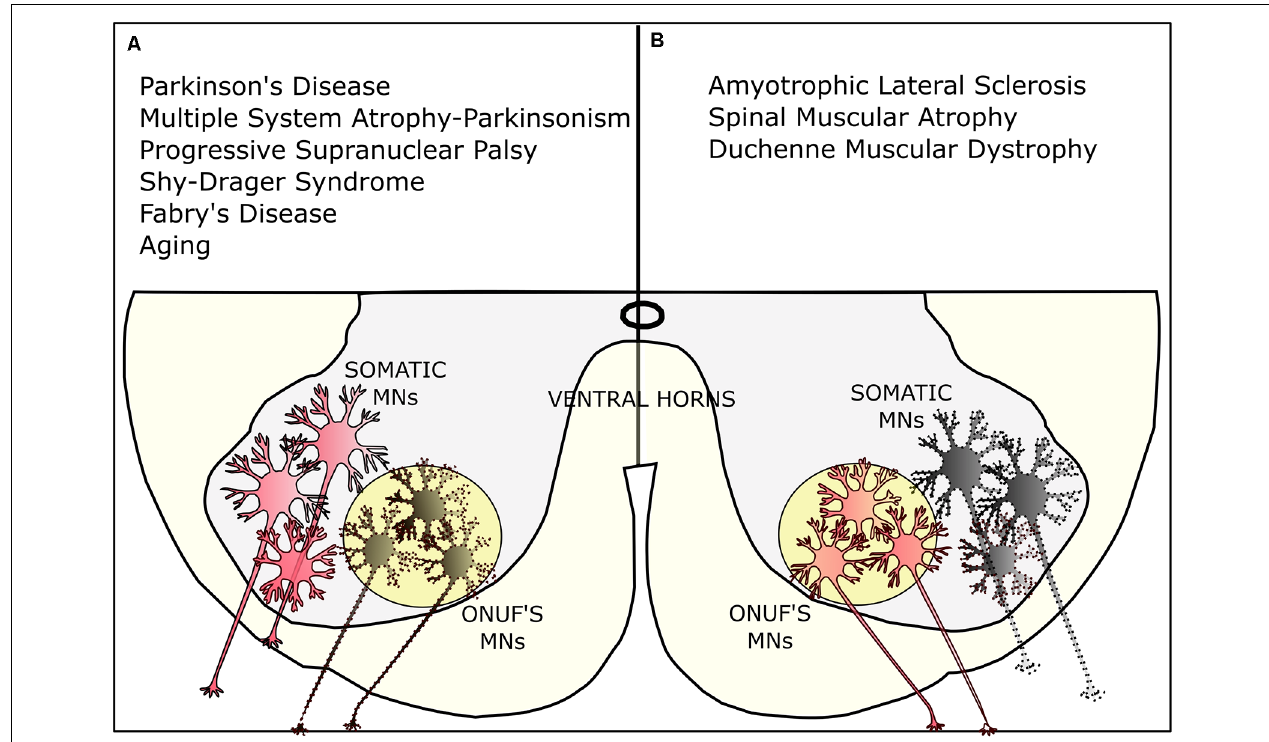
FIGURE 4 | Selective vulnerability of Onuf’s MNs. (A) Onuf’s nucleus is affected in several neurodegenerative diseases, such as Parkinson’s disease (PD) and multiple system atrophy (MSA) Parkinsonism, the progressive supranuclear palsy (PSP), the Shy-Drager-Syndrome, and Fabry’s disease. Onuf’s MNs are also degenerating in aging-related pathologies, leading, for instance, to urinary incontinence. (B) On the contrary, Onuf’s nucleus is spared in certain neurodegenerative diseases where, conversely, somatic MNs are degenerating: for instance, Onuf’s MNs are preserved in amyotrophic lateral sclerosis (ALS), spinal muscular atrophy (SMA), and duchenne muscular dystrophy (DMD). Dotted lines represent dying/affected